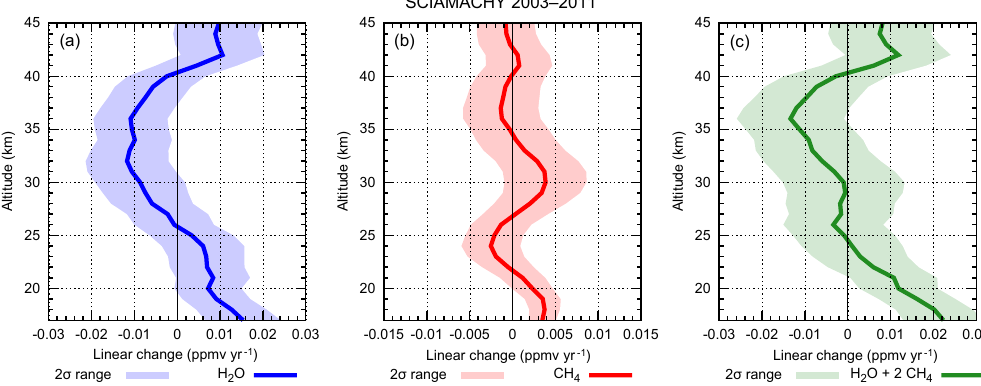
Figure 11. Calculated VMR linear changes of H 2 O (blue; a ) and CH 4 (red; b ) from 2003 to 2011 as a function of altitude. Methane data are from Noël et al. (2016). (c) Potential water linear changes derived from the combination of H 2 O and CH 4 linear changes.